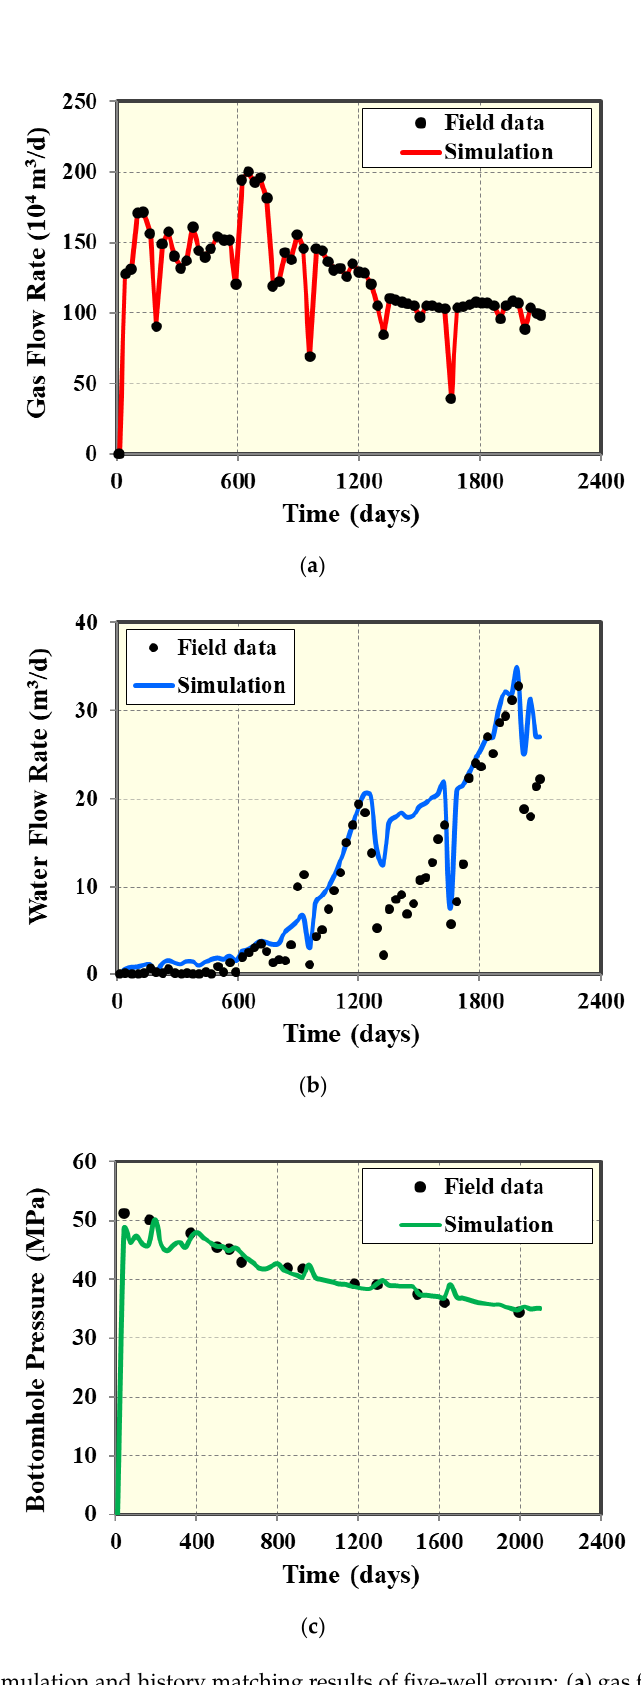
flow rate; ( c ) BHP. The points represent the field data while the solid lines represent the simulated